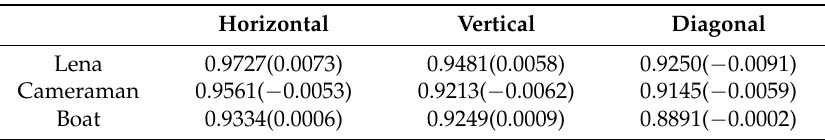
Table 3. The correlation coefficient of adjacent pixels.